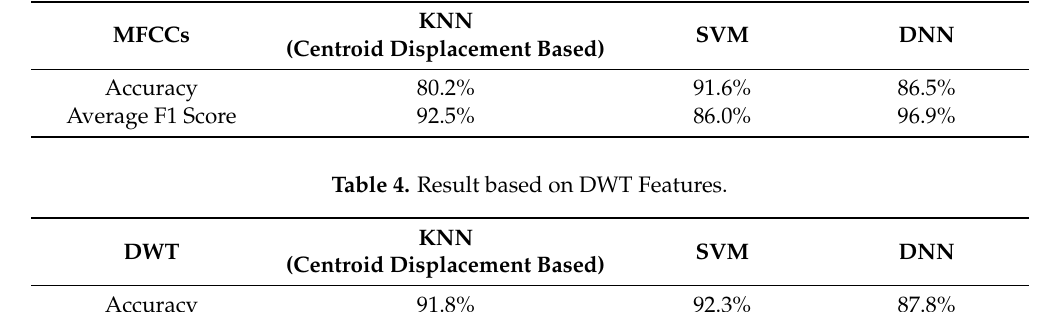
Table 3. Improved Result based on MFCCs Features.